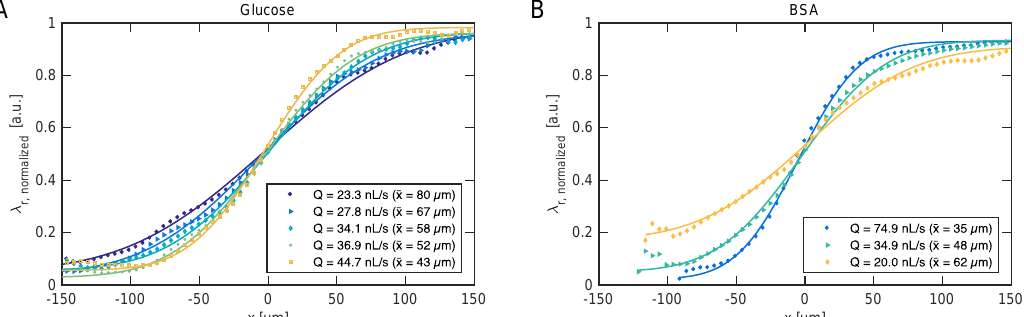
Figure 4. Experimental diffusion profiles for ( A ) glucose and ( B ) BSA. Higher flow rates ( Q in the legends) lead to sharper transition (smaller ¯ x ) at a given downstream position. Solid lines indicate best fits to Equation